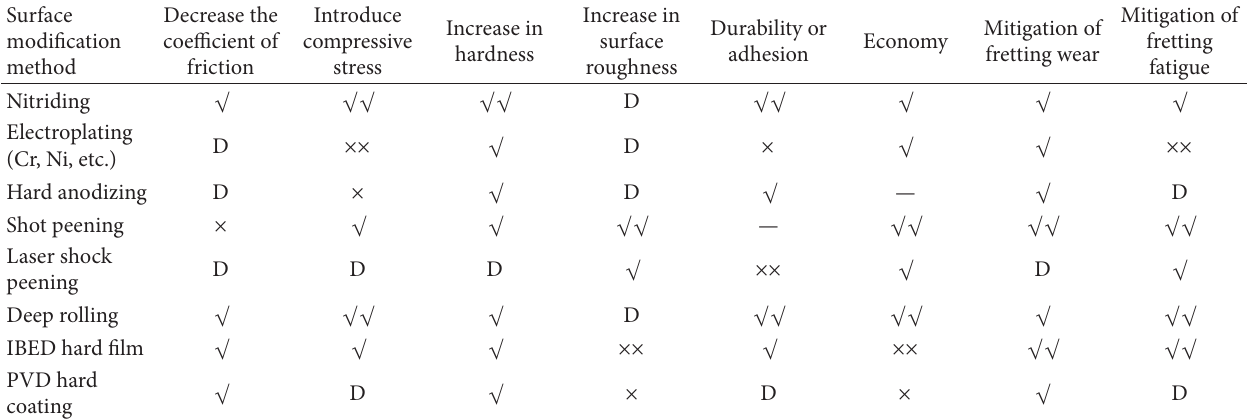
Table 3: Effect of surface modification techniques on fretting